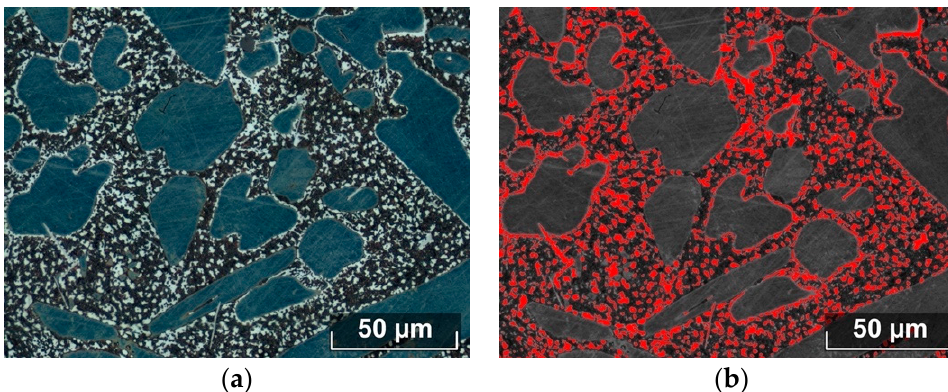
Figure 3. Darkened ferrite, light gray σ -phase, and blue austenite ( a ) in Steel 4 microstructure after annealing was provoked at 850 °C for 60 min and a phase identification using automated image analyzer ( b ). This etching darkens ferrite areas that have not transformed into a σ -phase, light gray areas of the σ -phase, and blue austenite (Figure 3a). The obtained image can be binarized by grayscale threshold and used for the automated phase volume fraction analysis (Figure 3b). Volume fraction of σ -phase (red in Figure 3b) was